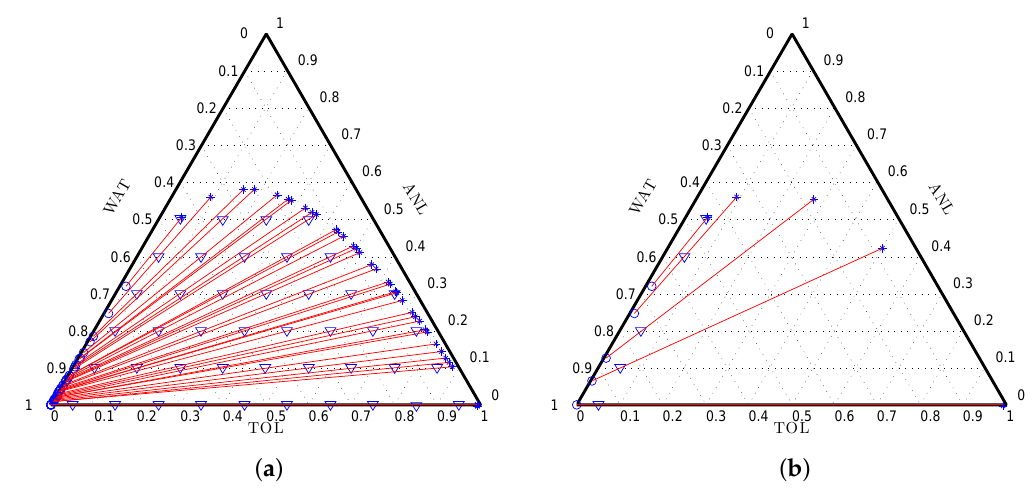
Figure 1. D-optimal design of experiments for system WAT-TOL-ANL: ( a ) candidate initial mixtures and corresponding tie-lines; and ( b ) tie-lines corresponding to D-optimal design (symbols: o, Phase 1 composition; ∗ , Phase 2 composition; (cid:79) , initial mixture composition; tie lines in red).